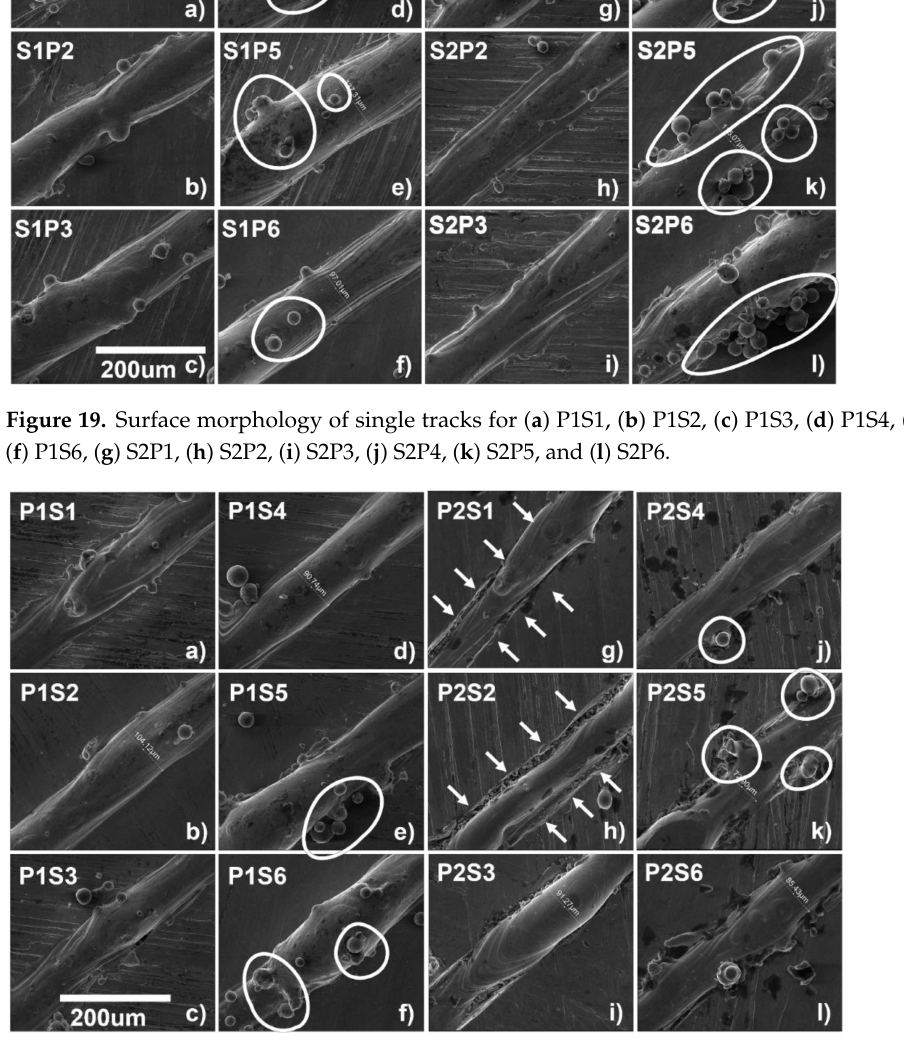
Figure 20. Surface morphology of single tracks for ( a ) P1S1, ( b ) P1S2, ( c ) P1S3, ( d ) P1S4, ( e )